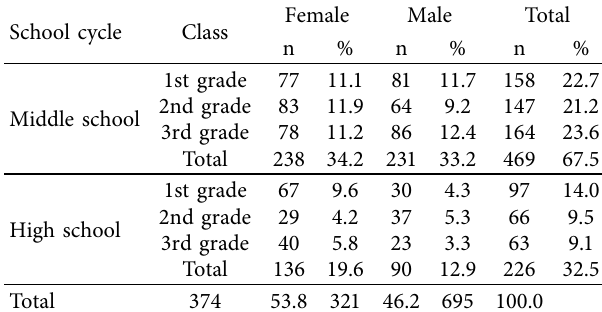
Table 1: Percentage of pupils by gender and school